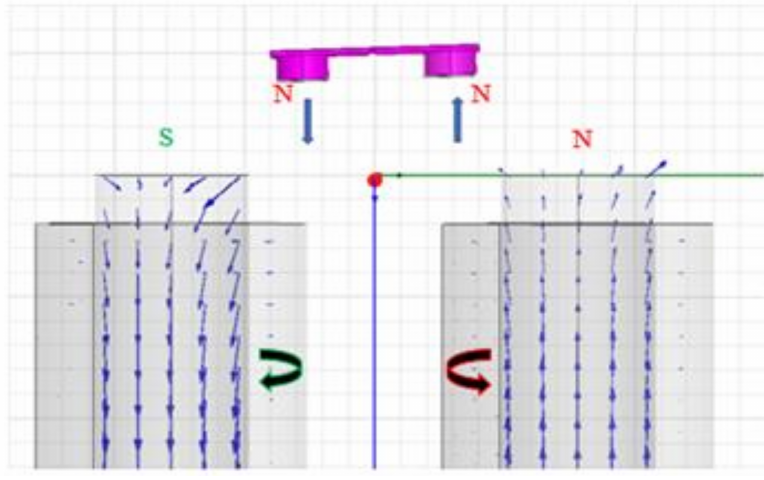
Figure 2. Simulation of torque T e at the rotation angle θ and applied voltage V